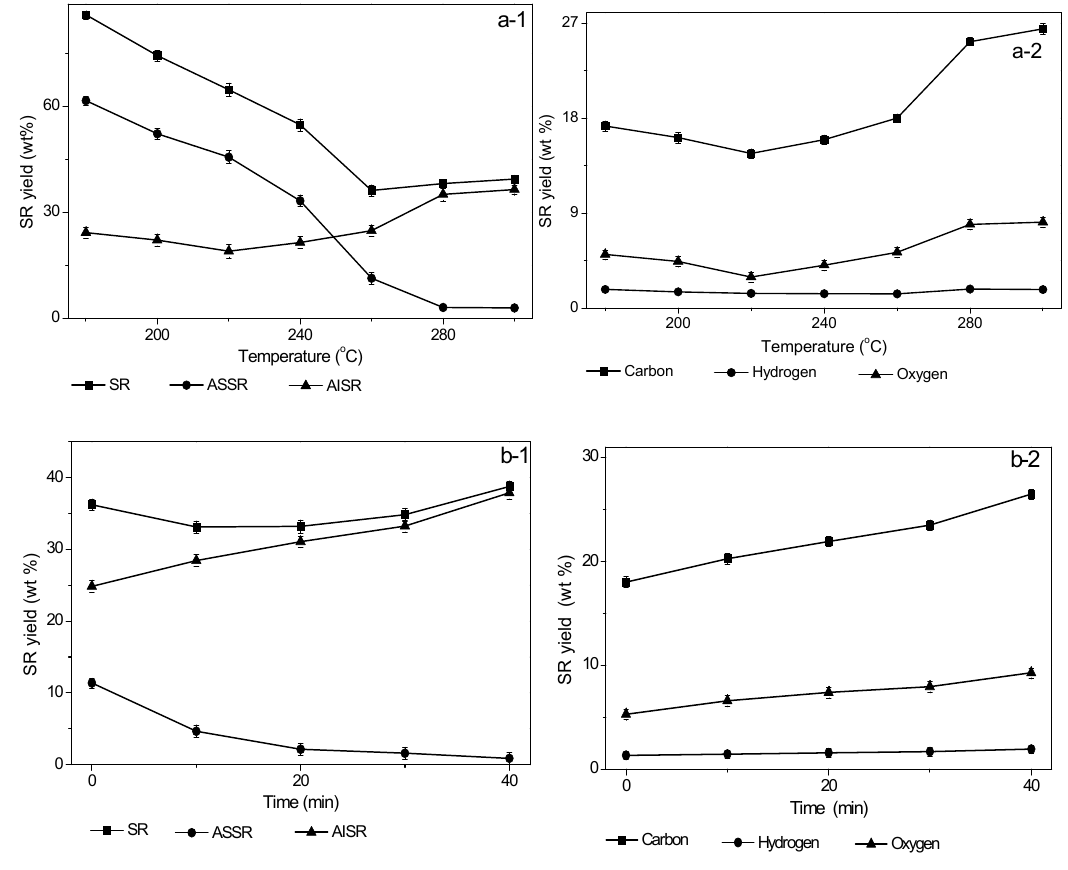
Figure 2. Effect of ( a ) temperature and ( b ) retention time on the yield of solid